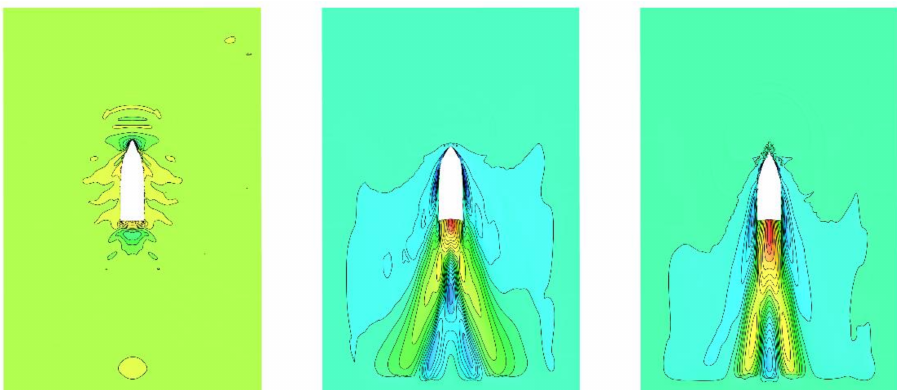
Figure 5. Wave shape (Fourier coefficient: left : 0.2, middle : 1, right : 1.6). Different colors represent different wave heights, which gradually decrease from the tail to the distance.